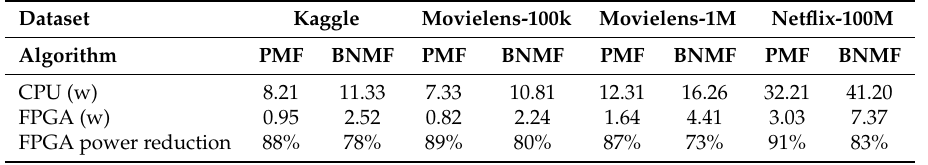
Table 4. Power (w) and FPGA power reduction of PMF and BNMF algorithms for the CPU and FPGA